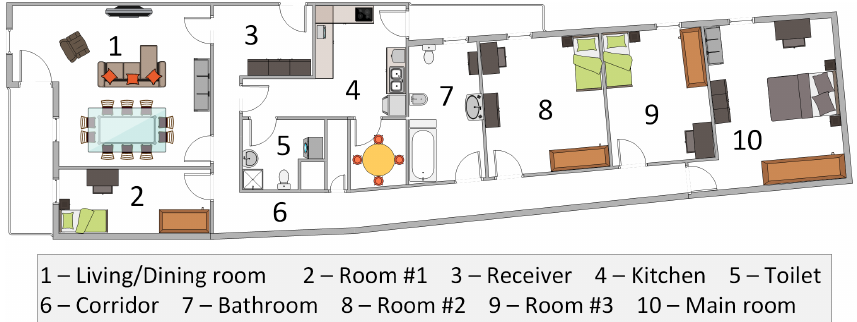
Figure 9. Plane of the house where the “devices module” is